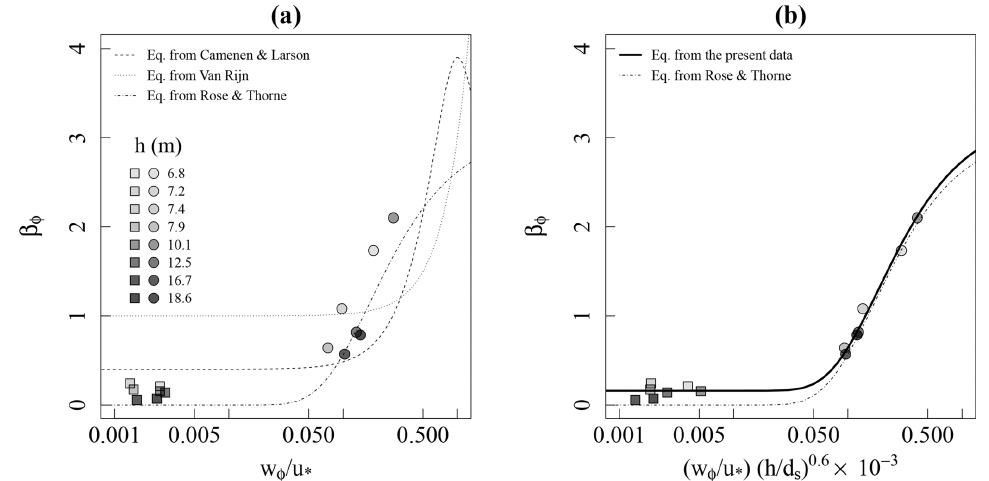
Figure 8. (a) Ratio of sediment to eddy diffusivity β φ as a function of the ratio w φ /u ∗ , with points shaded according to the water level h . (b) Idem, after correction of the ratio ( w φ /u ∗ ). Circles and squares are the mean values of β s and β f calculated per site,